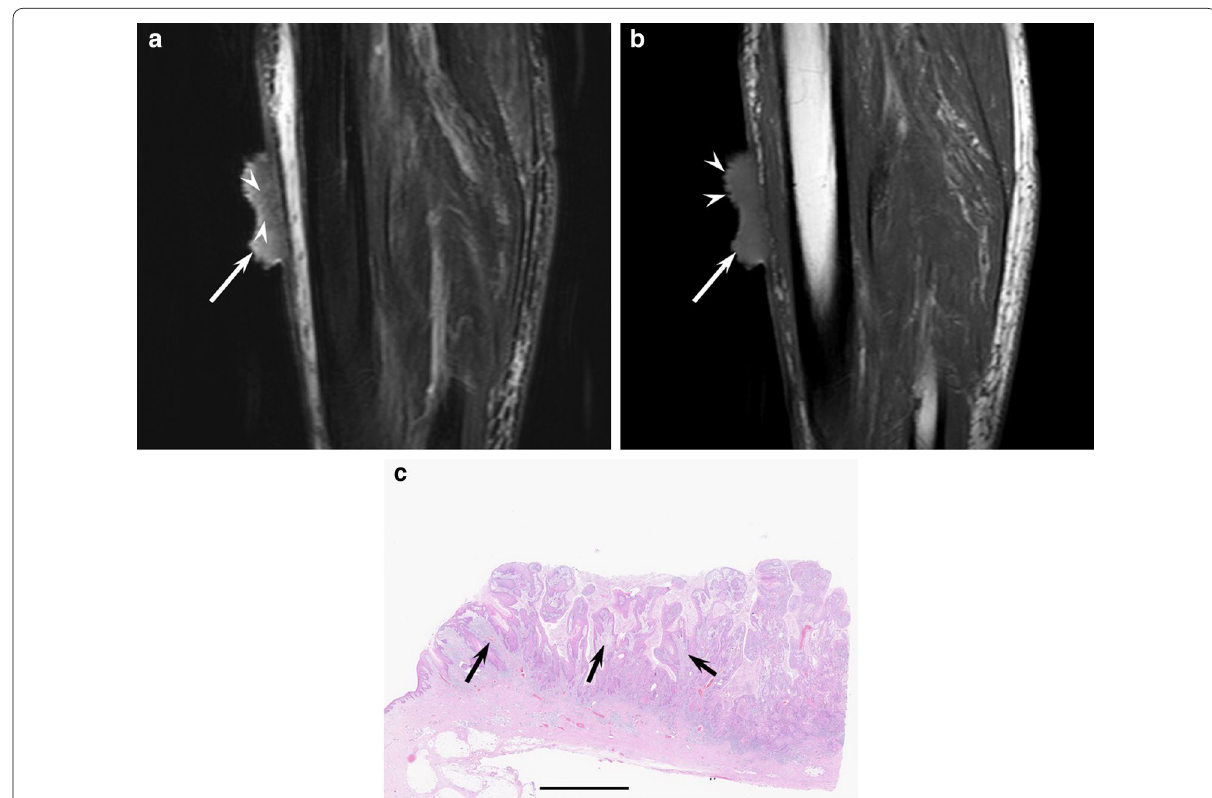
Fig. 3 An 86‑year‑old male with squamous cell carcinoma on the lower leg. a Sagittal fat‑suppressed T2‑weighted image showing an elevated and flattened mass (arrow) with superficial ulcer formation and linear hyperintensity (arrowheads). b Sagittal T1‑weighted image showing a mass (arrow) with superficial irregular margins (arrowheads). c Histological specimen (H&E stain; scale bar, 5 mm) showing invasive squamous cell carcinoma nests surrounded by stromal components with infiltration cells